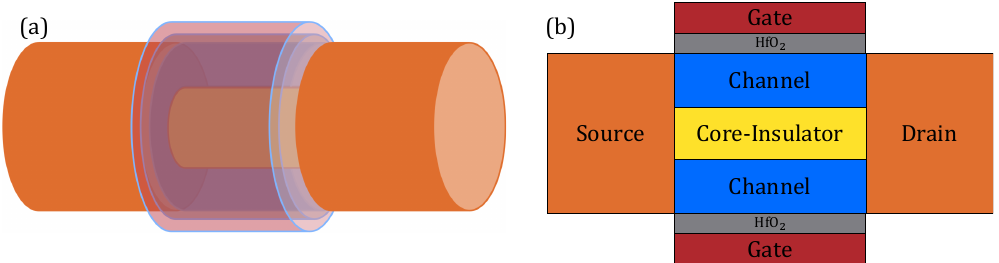
Figure 1. The schematic 3D structure and cross section of CIGAA: ( a ) 3D view of CIGAA; ( b ) cross-sectional view of CIGAA. The illustrations are not depicted proportionally to the really devices; we made some exaggeration for a clear